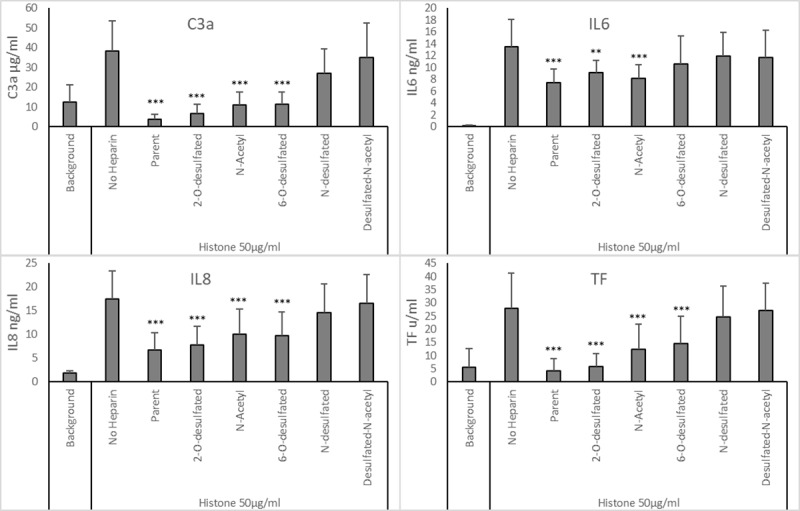
Ability of selectively desulfated heparin to attenuate histone induced inflammatory responses in whole blood.Histones, 50μg/ml, and differently desulfated heparins, 200 μg/ml, were added to whole blood and incubated for 6 hours. Released C3a, IL-6 and IL-8 were measured in plasma and tissue factor was measured from the cellular component. Analysis of data was carried out using Dunnett’s multiple comparison with no heparin (histones only) as the control sample, * = p < 0.05, ** = p < 0.01, *** p <0.001. Error bars = standard deviation of the average from 6 donors.